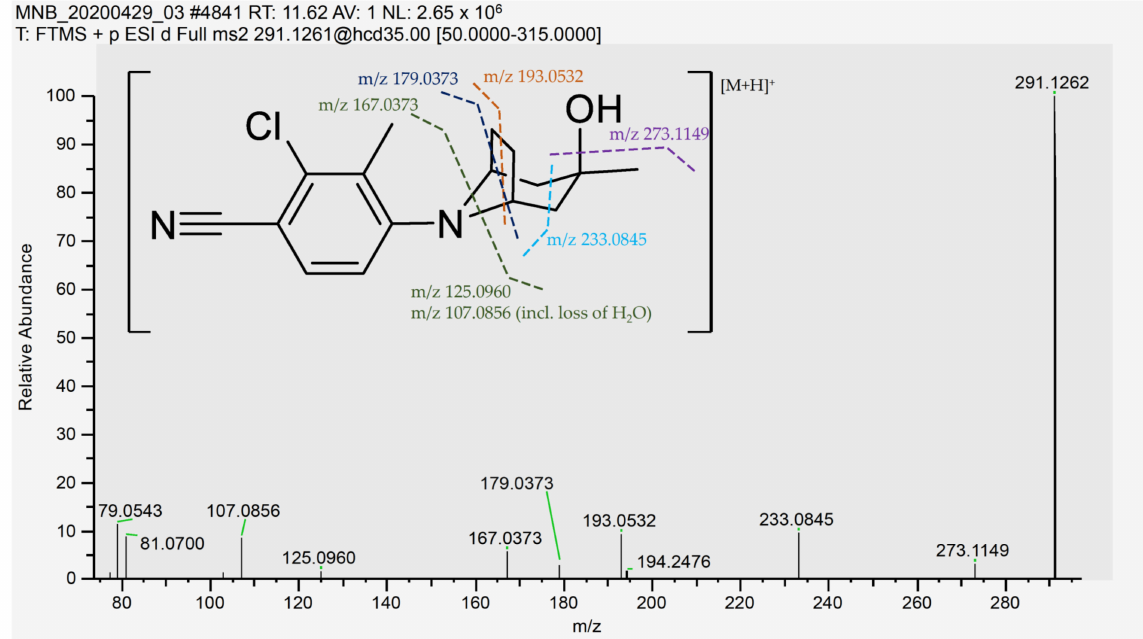
Figure 2. MS/MS spectrum and suggested cleavage sites for the product ions of ACP-105 with the pre-cursor ion [C 16 H 20 ClN 2 O] + with m / z 291.1262. The suggested cleavage sites do not represent the final hydrogen distribution between the detected fragment and the neutral loss for all fragments, full information available in Table A1 in Appendix